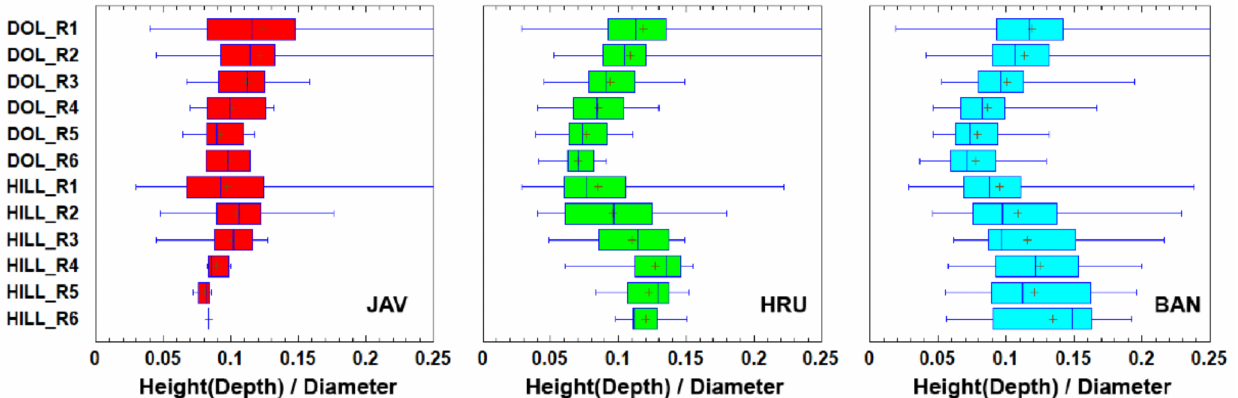
Figure 12. Box-whisker plots of doline depth per diameter and hill height per diameter values. The plus signs denote the mean values of the distributions. The boxes mark the ranges between the lower and upper quartiles. JAV: Javorniki; HRU: Hrušica; and BAN: